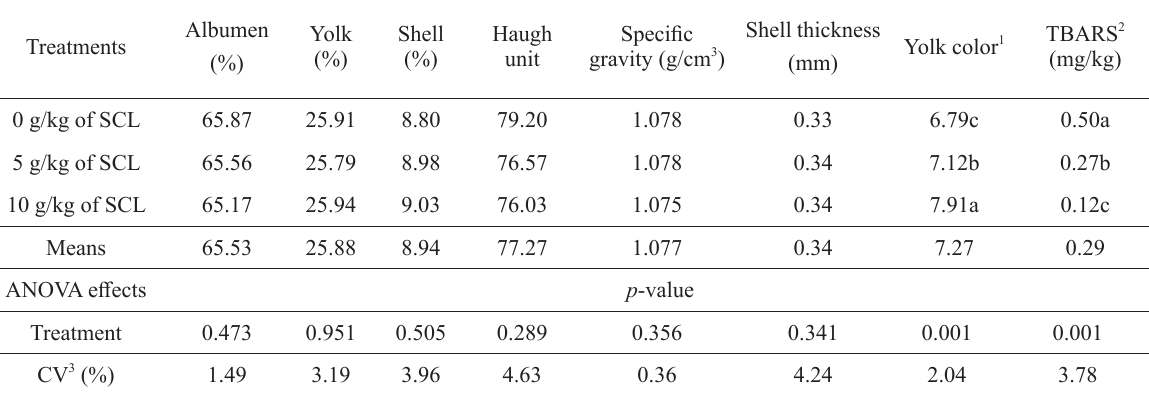
Quality characteristics and lipid oxidation of yolk from laying hens fed diets with increasing levels of Syzygium cumini leaves